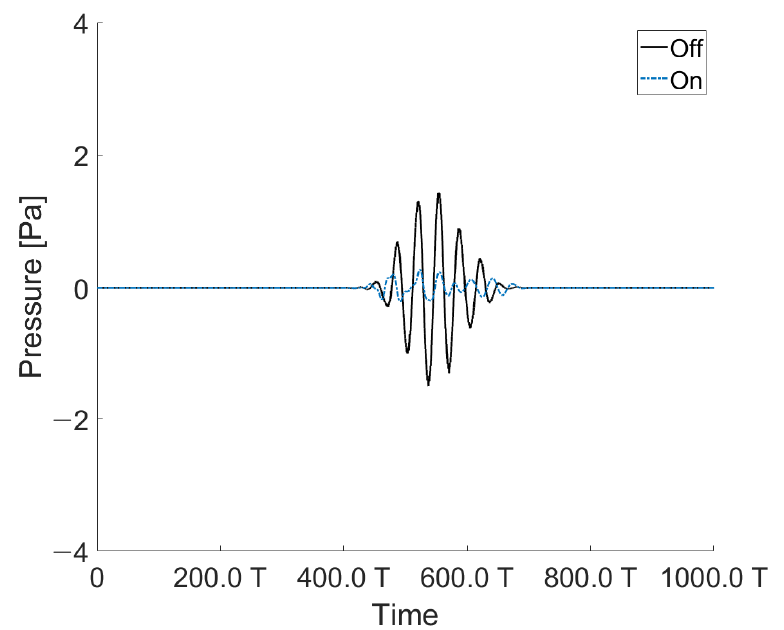
Figure 10. Acoustic signal reduction measured by a hydrophone located at the same angle as the angle of incidence (at 10°).